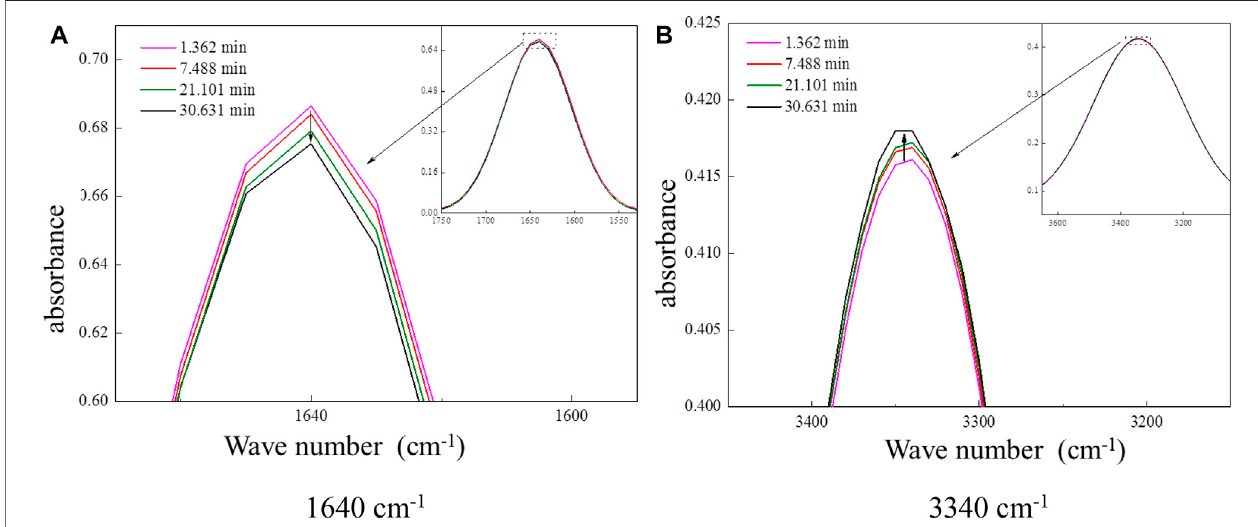
FIGURE 7 | Changes of the DHOPA absorption peak at 1,640 and 3,340 cm − 1 in the course of reactions. (A) 1,640 cm − 1 (B) 3,340 cm − 1 .